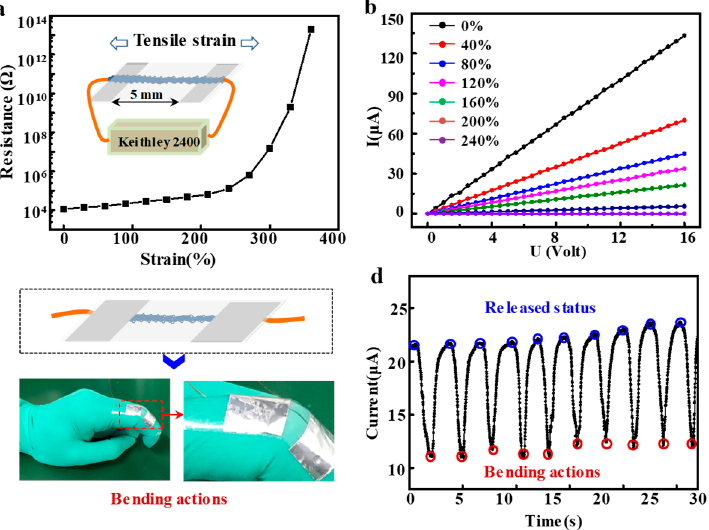
Figure 12. ( a ) Resistances of strain sensors with different tensile strains. ( b ) I–V characteristics of strain sensor under different tensile strains. ( c ) Images of forefingers assembled with fibrous sensors to record the electric current strength during the bending and release actions. ( d ) Electric current strength changes of the fibrous sensors after different cycles of bending and